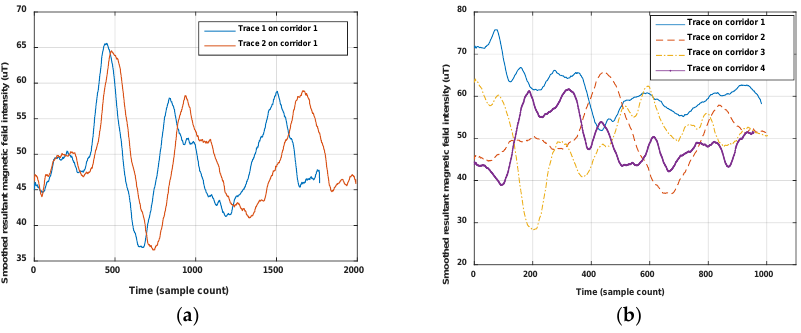
Figure 4. Comparison of magnetism sequences measured in the same corridor and different corridors: ( a ) Smoothed magnetism sequences generated in the same corridor; ( b ) Smoothed magnetism sequences generated in different corridors.